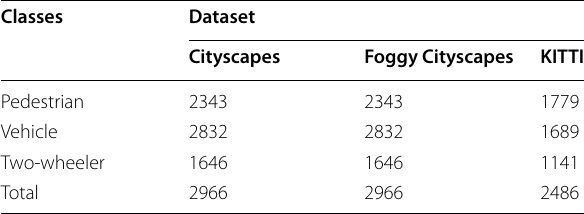
The last line indicates the number of images in each dataset